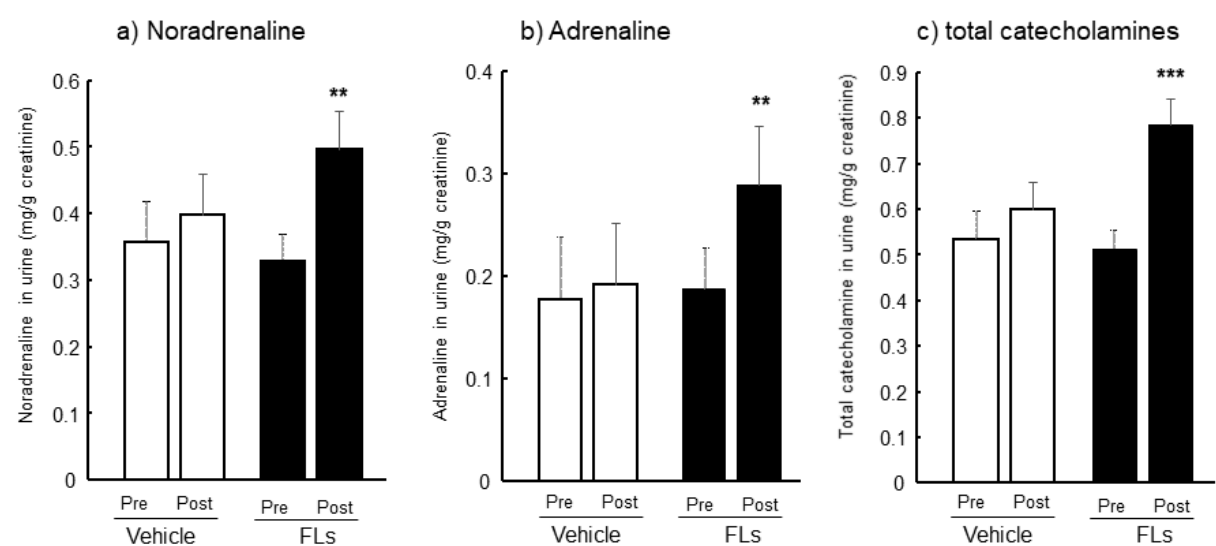
Figure 2. Twenty-four-hours urinary catecholamine (CA)s both pre-and post-oral administration of vehicle or 50 mg/kg flavan-3-ol (FL) s in mice. Noradrenaline (NA, ( a ), adrenaline (AD, ( b ), and total CAs ( c ). The values represent the mean ± standard deviation (each group, n = 8). ** p < 0.01, *** p < 0.001 (two-way ANOVA, followed by the post -Dunnett’s test).